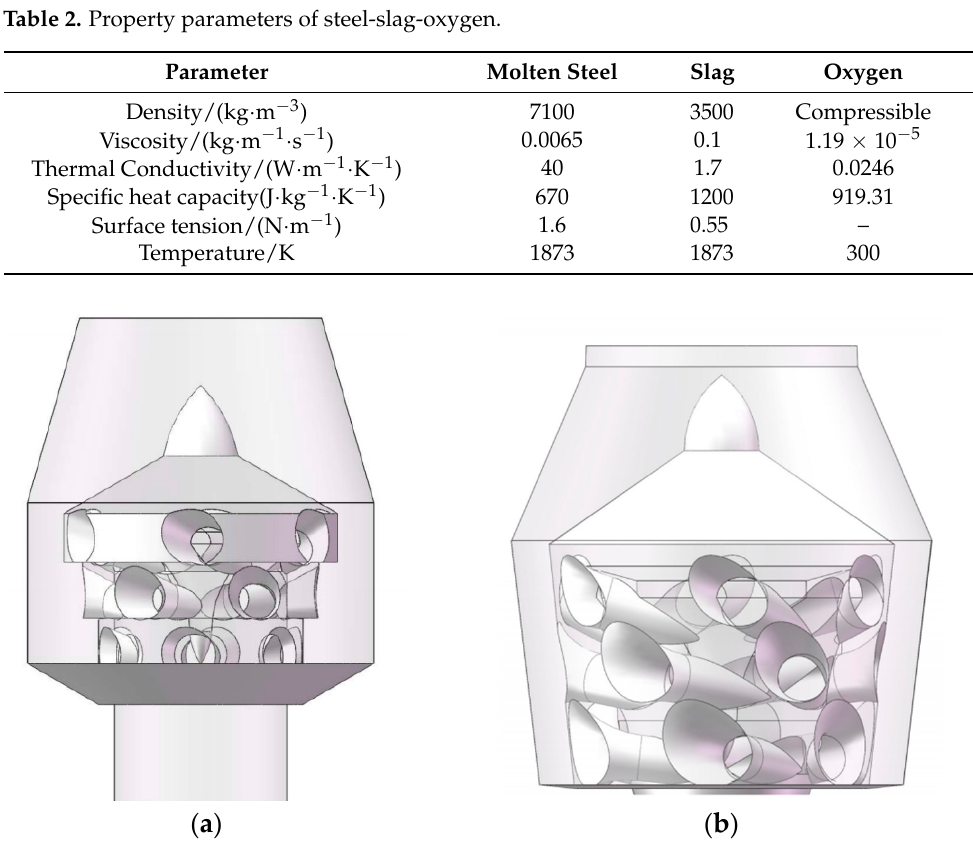
Figure 6. Comparison between the pre-modified structure and the modified structure: ( a ) pre-modified model; ( b ) modified model.